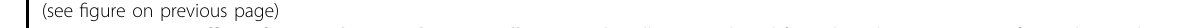
Fig. 3 Synergistic effect of LEN and IM on Ph + ALL cells. KOPN57bi cells were cultured for 72 h in the assays A-G or for 14 days in the colony formation assay I in the presence or absence of either 5 μ M LEN or 0.5 μ M IM alone (Selleck Chemicals; Houston, TX), or both. The results were compared by unpaired t -test. A Thymidine uptake assays. The LEN-induced inhibition of thymidine uptake was signi fi cantly ( p < 0.01) enhanced to 87.4 ± 1.2% in the presence of IM when compared with LEN alone (34.5 ± 2.5%). B AlamarBlue cytotoxic assays. Leukemia cells were cultured in the presence or absence of reagents and followed by 5h-incubation with alamarBlue (Bio-Rad Laboratories, Hercules, CA, RRID:SCR_008426). The LEN- induced decrease in the cell viability was signi fi cantly ( p < 0.01) enhanced to 38.7 ± 2.6% in the presence of IM when compared with LEN alone (75.7 ± 8.8%). C Changes in CH50 of IM in the absence or presence of LEN in alamarBlue cytotoxic assays. alamarBlue cytotoxic assays were performed at different concentrations of IM in the presence or absence of 5 μ M LEN. The IC50 of IM was shifted to 0.088 μ M in the presence of LEN from 1.05 μ M in the absence of LEN. The X and Y axes indicate log concentrations of IM and cell viability, respectively. D Demonstration of synergism. alamarBlue cytotoxic assays were performed at 6 concentrations (0.07, 0.2, 0.67, 2.0, 6.0, and 18 μ M) of LEN and/or 3 concentrations (0.125, 0.25, and 0.5 μ M) of IM. For The combination index (CI) was determined by median-effect analysis using the CalcuSyn software (Biosoft, Ferguson, MO). The CI was calculated in each culture condition and de fi ned as synergistic ≤ 0.8, additive 0.8<, and antagonistic 1.2<, according to the report by Chou TC et al. 47 . The X and Y axes indicate log concentrations of LEN and CI, respectively. E Flow cytometric analysis of apoptosis by PI staining. The marked increase in the subdiploid apoptotic fraction (42.3%) by LEN and IM treatment was revealed, although this population was only 14.3% or 18.1% by either LEN or IM treatment, respectively. The X and Y axes indicate DNA content and cell numbers, respectively. F Effect of pretreatment with pan-caspase inhibitor Z- VAD FMK. Cells were cultured with or without 30 min-pretreatment with pan-caspase inhibitor Z-VAD FMK (20 μ M), and fl ow cytometric analysis of PI staining was performed. The subdiploid population was decreased to 12.2% accompanied with an increase in the G0/G1 population (74.4%) by pretreatment. The X and Y axes indicate DNA content and cell numbers, respectively. G Flow cytometric analysis of apoptosis by Annexin-V/PI staining. The marked increase in the late apoptotic population from 9.5 to 53.0% (in the right/upper quadrant) and the decrease in the viable population from 84.8 to 28.0% (in the left/lower quadrant) were demonstrated by LEN and IM treatment. The X and Y axes indicate log fl uorescence intensities of Annexin-V and PI, respectively. H Flow cytometric analysis of apoptosis by cleaved caspase 3 antibody. Cells were cultured with or without 30 min-pretreatment with pan-caspase inhibitor Z-VAD FMK (20 μ M), and were stained using active caspase-3 apoptosis kit (BD Biosciences, San Jose, CA, USA) after permeabilization and fi xation. The X and Y axes indicate log fl uorescence intensities and cell numbers, respectively. I